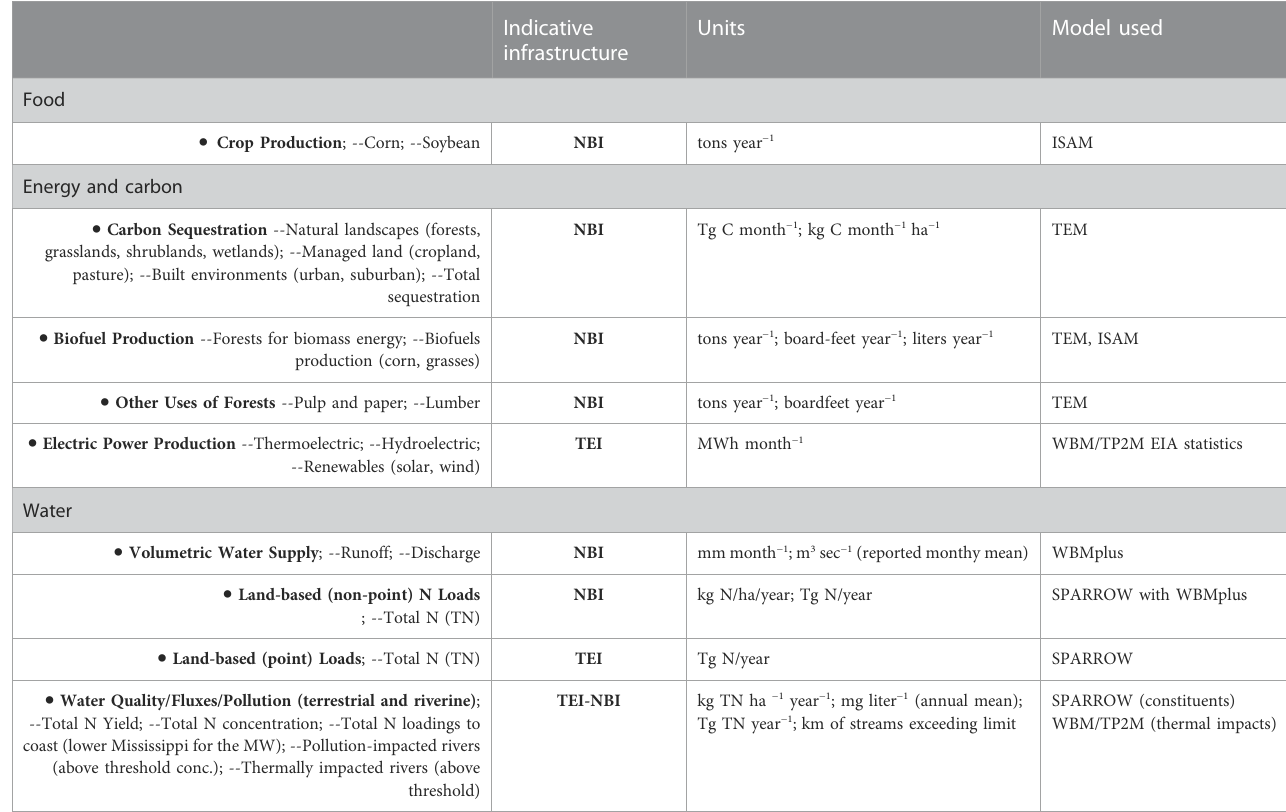
TABLE 3 Core variables computed by the suite of C-FEWS models, organized by sector and by assignment as representative of the performance of different infrastructures.Thesevariables are usedtoevaluatesystem impacts from the climate andnon-climate factorsmanipulated to produce the contrasting scenariosgiven in Table